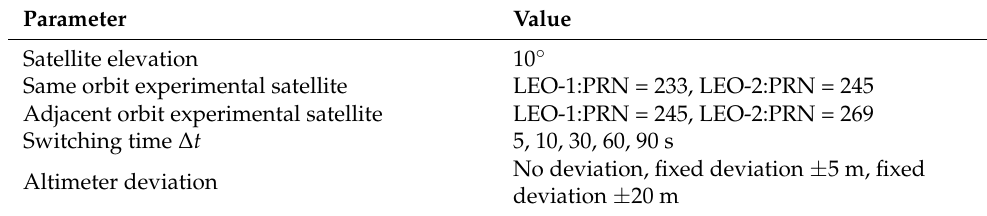
Table 3. The main parameter settings of the experimental